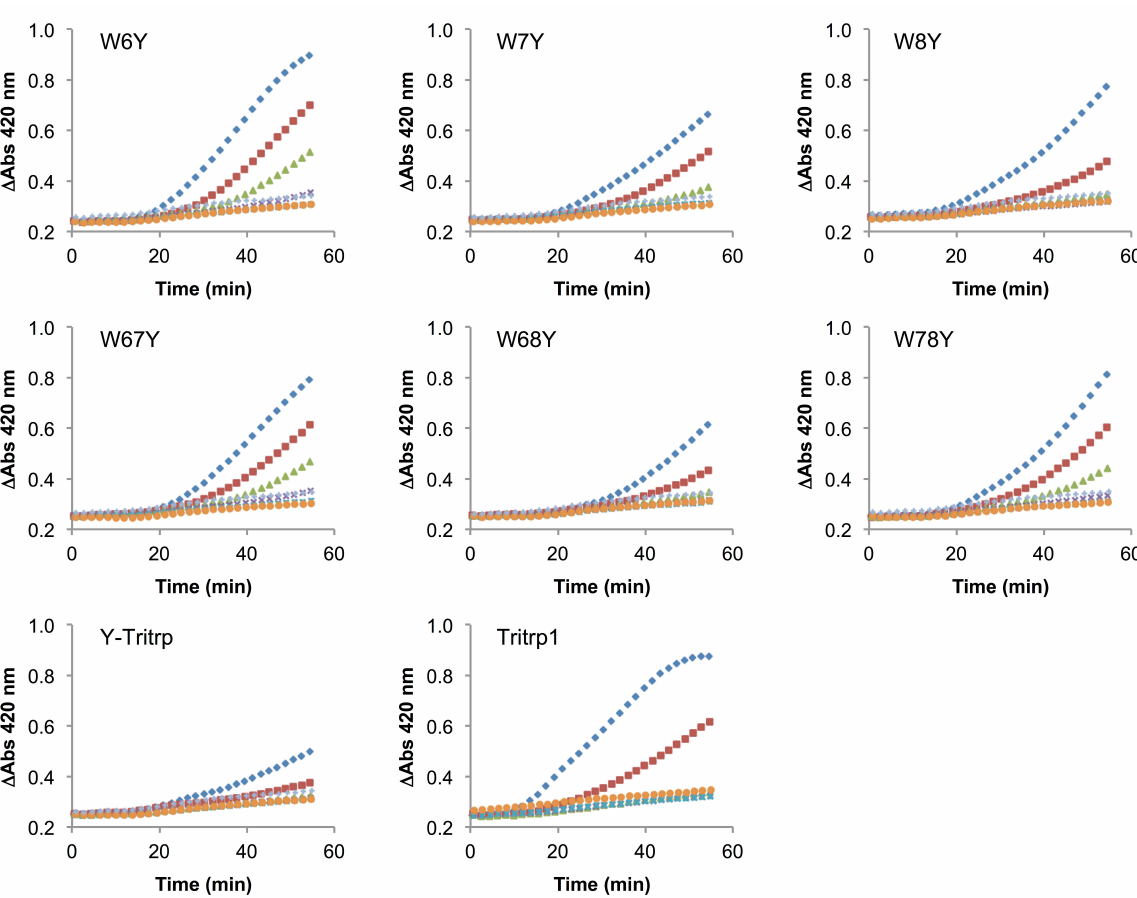
Figure 8. Inner membrane permeabilization induced by Tritrp1 and Trp-to-Tyr-substituted Tritrp1 analogs. Peptide concentrations were MIC ( ♦ ), 1 / 2 MIC ( (cid:132) ), 1 / 4 MIC ( ▲ ), 1 / 8 MIC ( × ), Table 1. For peptides with a range of MICs, the higher concentration was used. The results are the average of three independent experiments, and the standard deviation (SD) for two selected peptide concentrations are depicted in Figure